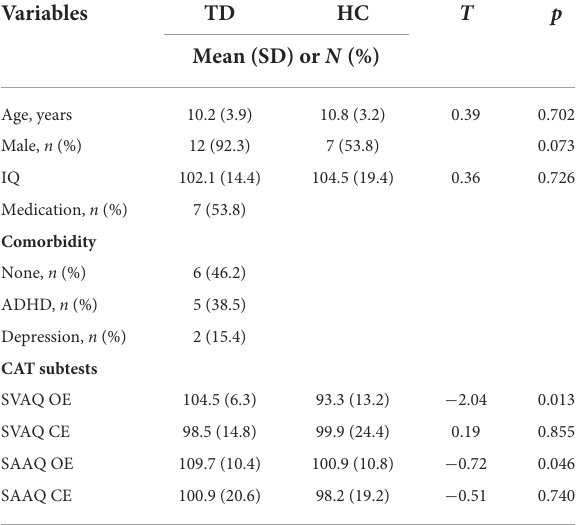
TABLE 1 Demographic and clinical characteristics of the patients with TD and